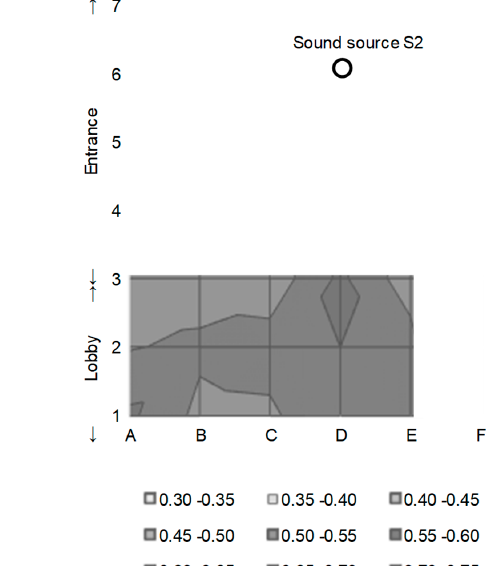
Figure 10. Distribution of intelligibility in the room: ( a ) assuming an utterance in the lobby and ( b ) assuming an utterance in the entrance hall.